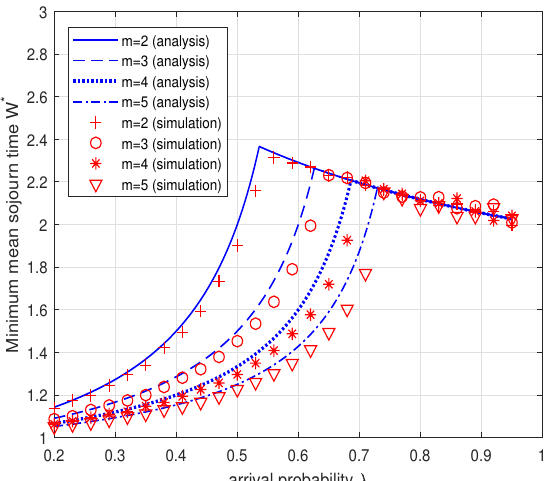
Figure 9. Minimum mean sojourn time W ∗ while maximizing the system throughput for the varying λ when m = 3. According to the Corollary 2, we set µ 1 = 1 and µ 2 = 1 when λ √ √ > 1 − λ when λ λ . and µ 2 = 1 − m